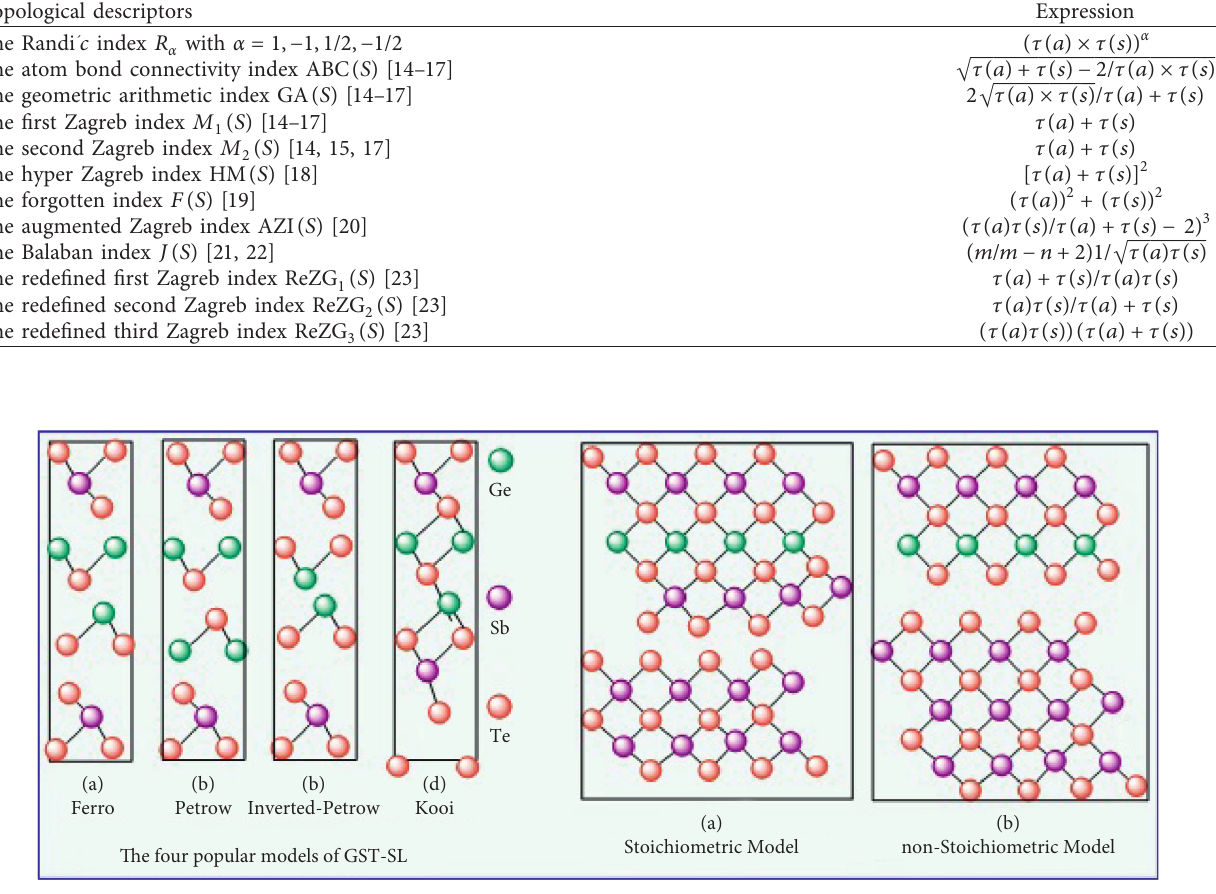
Figure 1: The general structure of ( GST − SL ) .